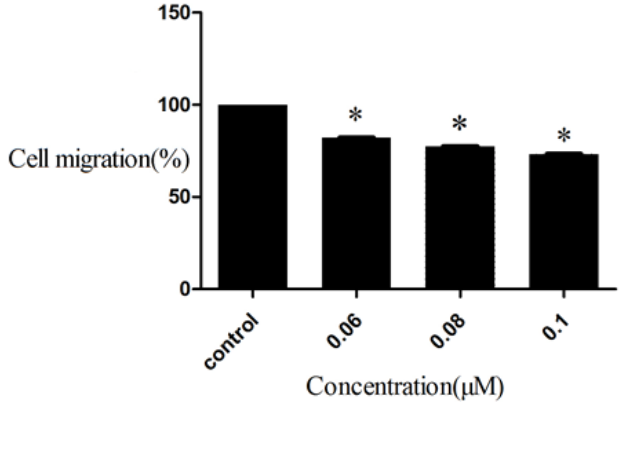
Figure 4. Inhibition to HepG2 Cell migration of compound D percentage of the control, which was defined as 100%. Data are plotted as the mean ± SD (* P < 0.05 vs.